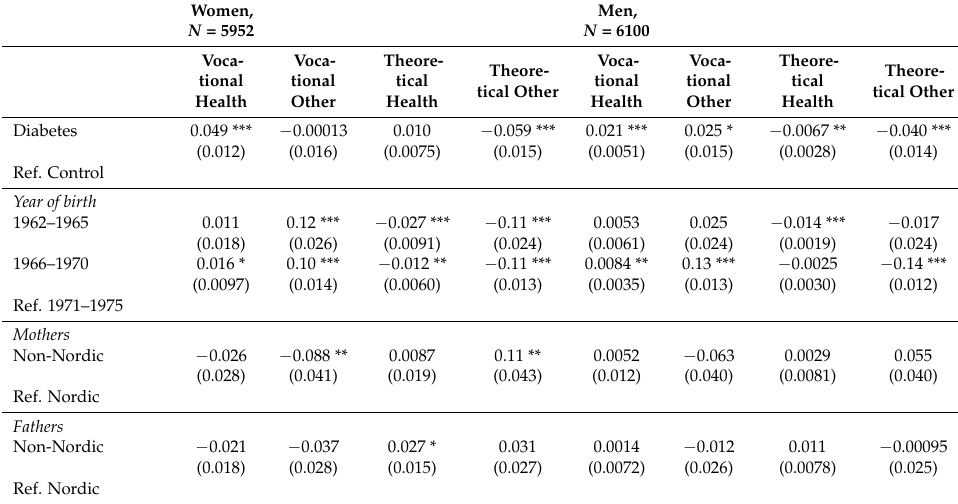
Table 7. Test with a more restrictive definition of health-oriented education: Average marginal effects of the probability of having different fields of upper secondary